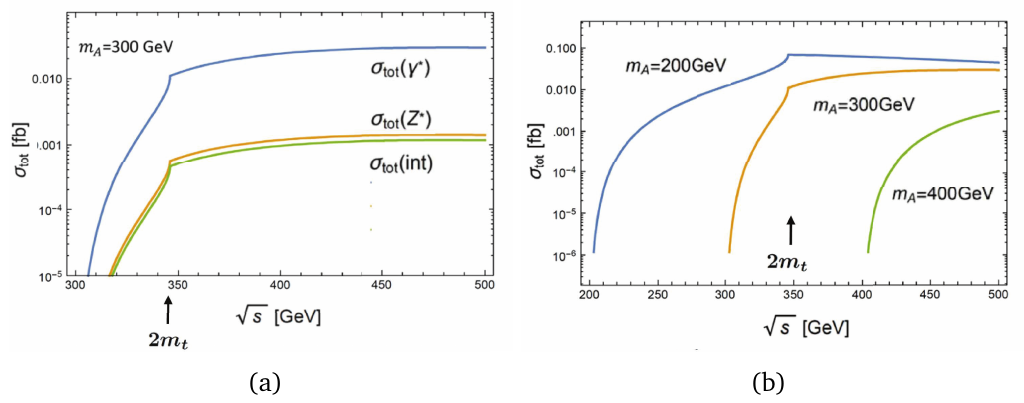
Figure 4: Total cross section for A 0 production in e + e − collisions:(a) Three compo- nents of cross section and (b) A 0 mass dependence of total cross section.